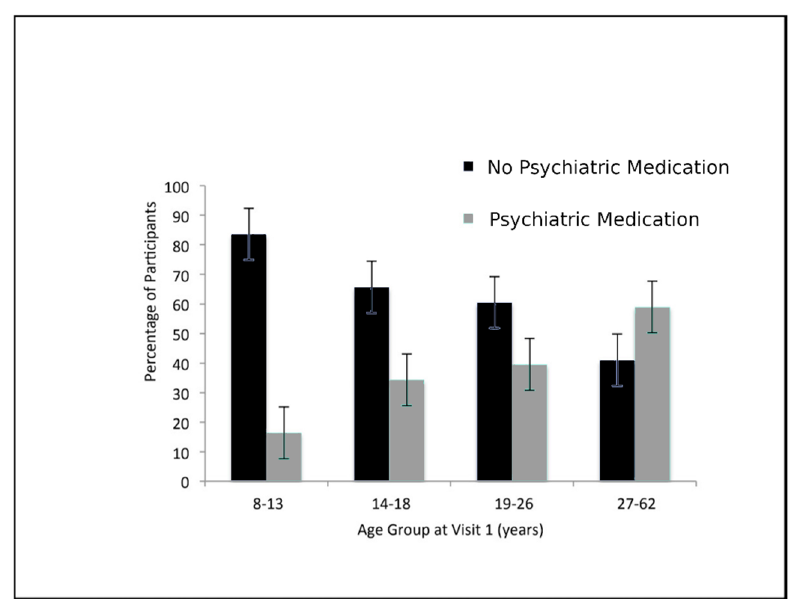
Figure 3. Psychiatric medication use by age group at visit 1. Individuals who used psychiatric medications were significantly older at visit 1 than those who did not use psychiatric medications.